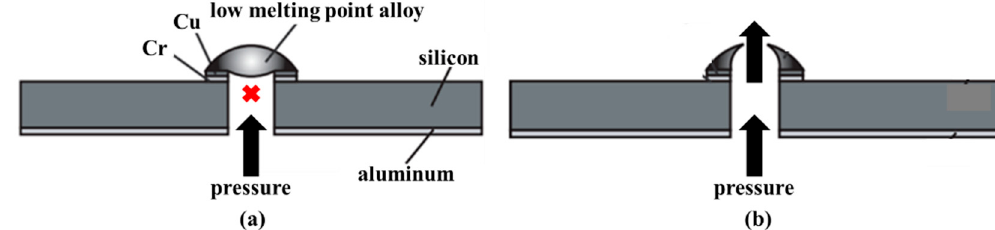
Figure 17. Scheme of the cross-section of the one shot microvalve based on low melting point alloy [105]: ( a ) In the closed position; ( b ) In the open position.